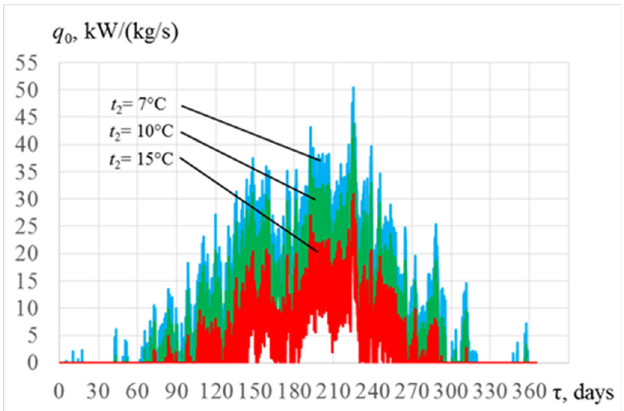
Figure 2. Changes of specific cooling capacities q 0.7 , q 0.10 and q 0.15 required for cooling ambient air with unit mass flow rate of 1 kg/s from its actual temperature t amb to t 2 = 7, 10 and 15 °C.